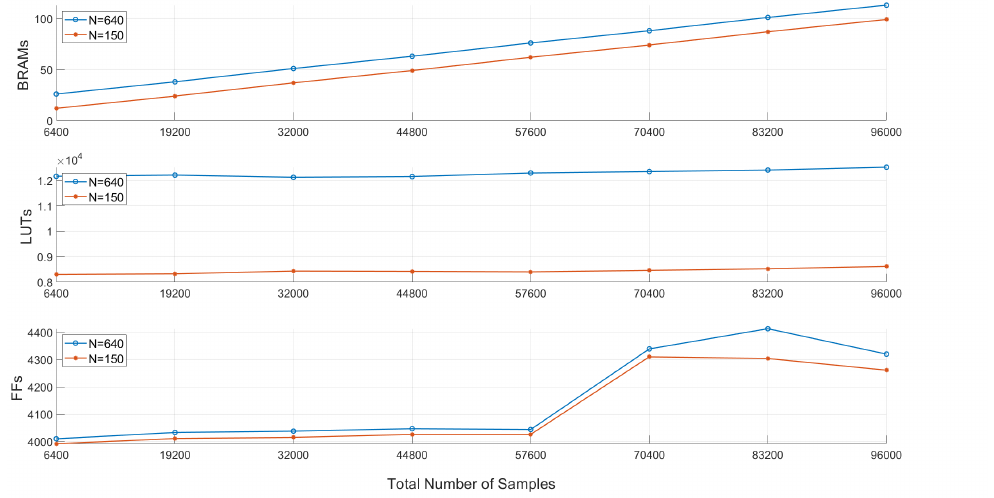
Figure 19. Resource utilization as a function of the image width equal to 640 samples (blue) and 150 samples